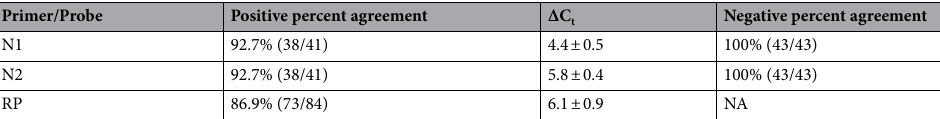
Table 1. Comparison of SARS-CoV-2 detection from unextracted clinical nasopharyngeal specimens using our multiplexed assay optimized for direct qRT-PCR of unextracted specimens compared to the original clinical diagnostic test results using the FDA emergency-use authorized CDC singleplex assay.